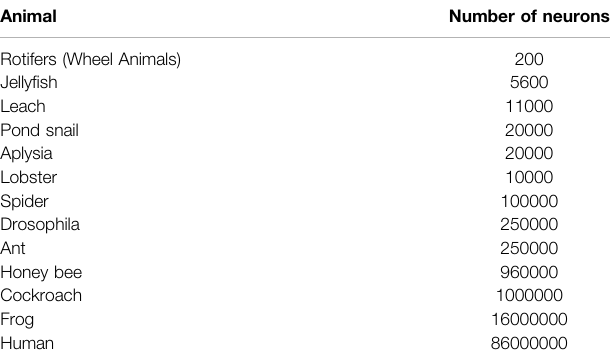
TABLE 1 | Dimension of the nervous system of simple living systems.